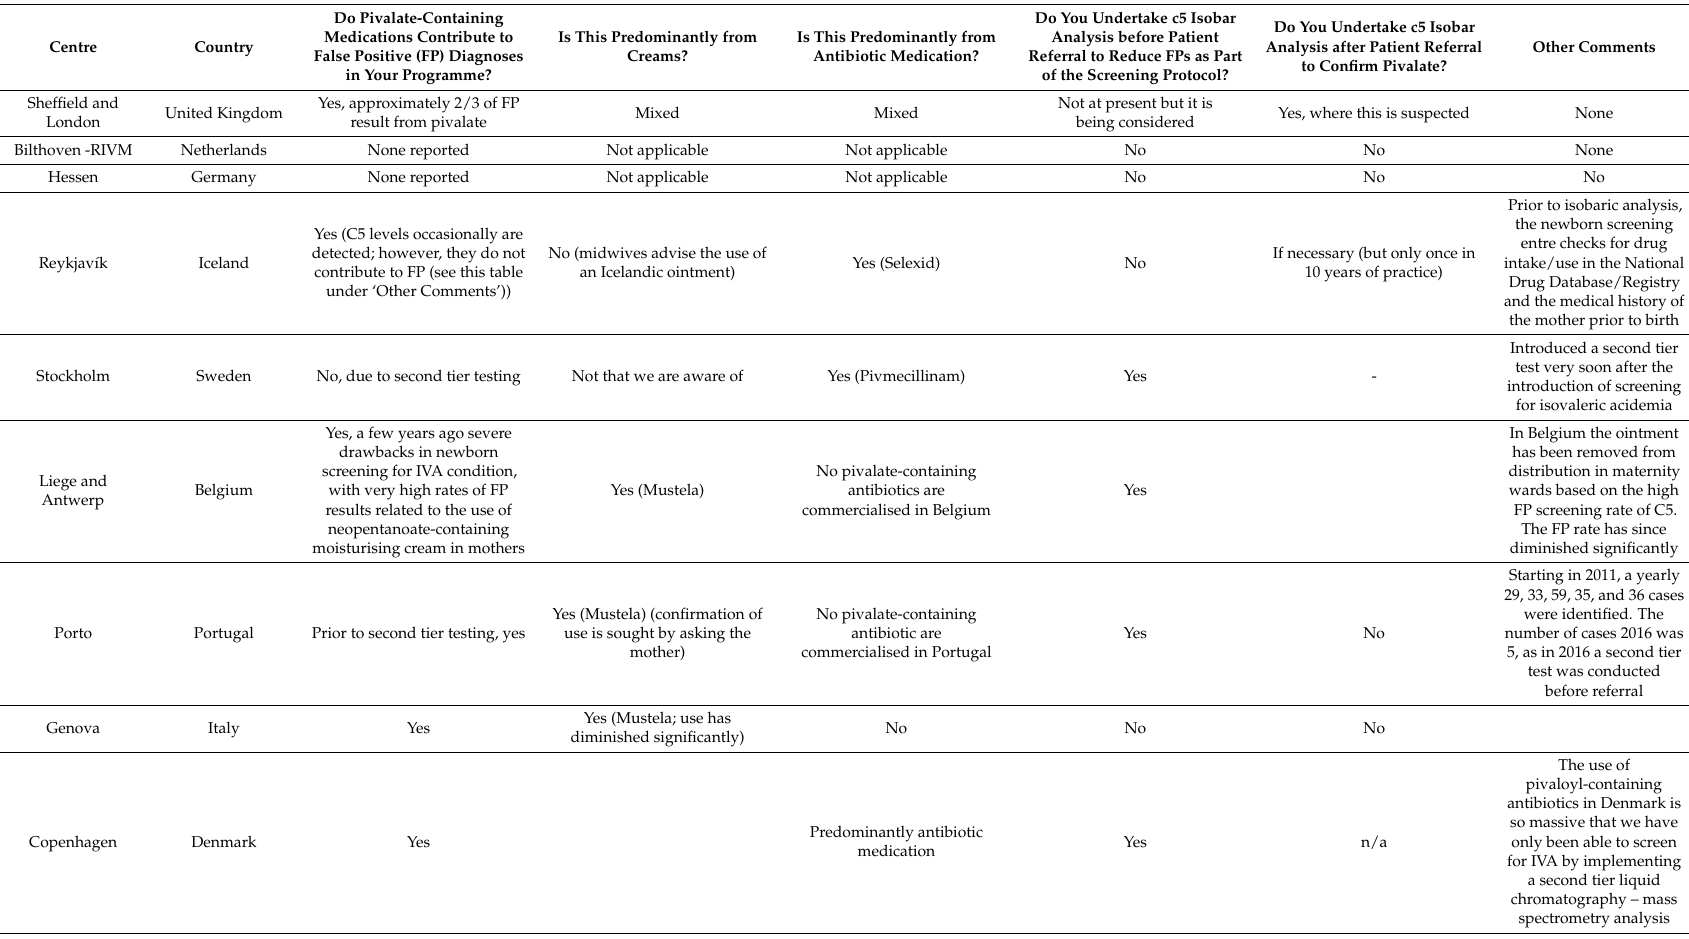
Table 1. Summary of results from a survey in centres from nine European